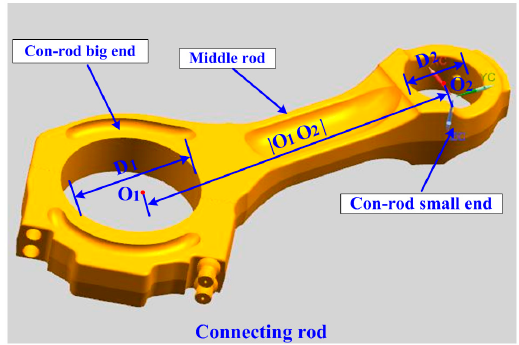
Figure 1. The connecting rod.